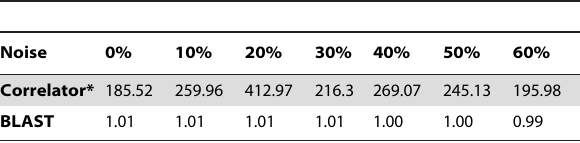
Table 6. Time (seconds) taken to process 303 objects in 100